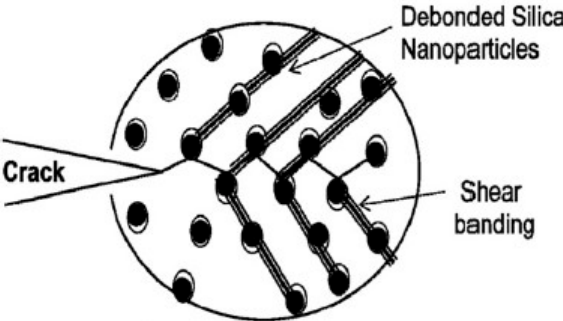
Figure 7. Schematic representation of plastic void growth and matrix shear banding mechanisms observed involved in the fracture of nanosilica-modified epoxy resins [29].